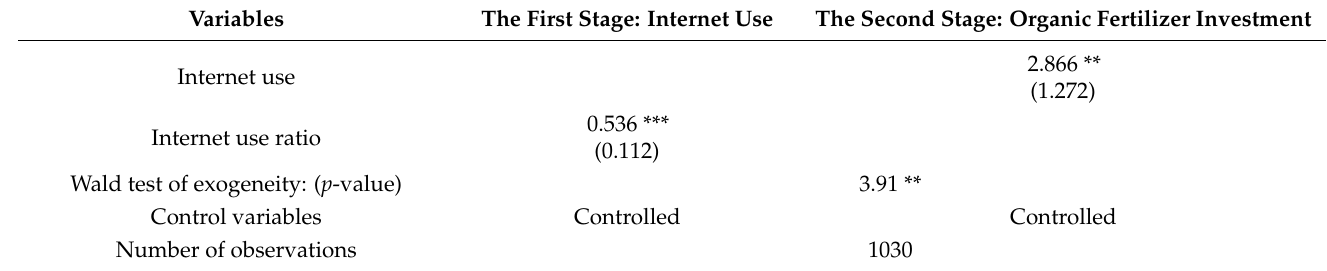
Table 3. Endogenous test results.